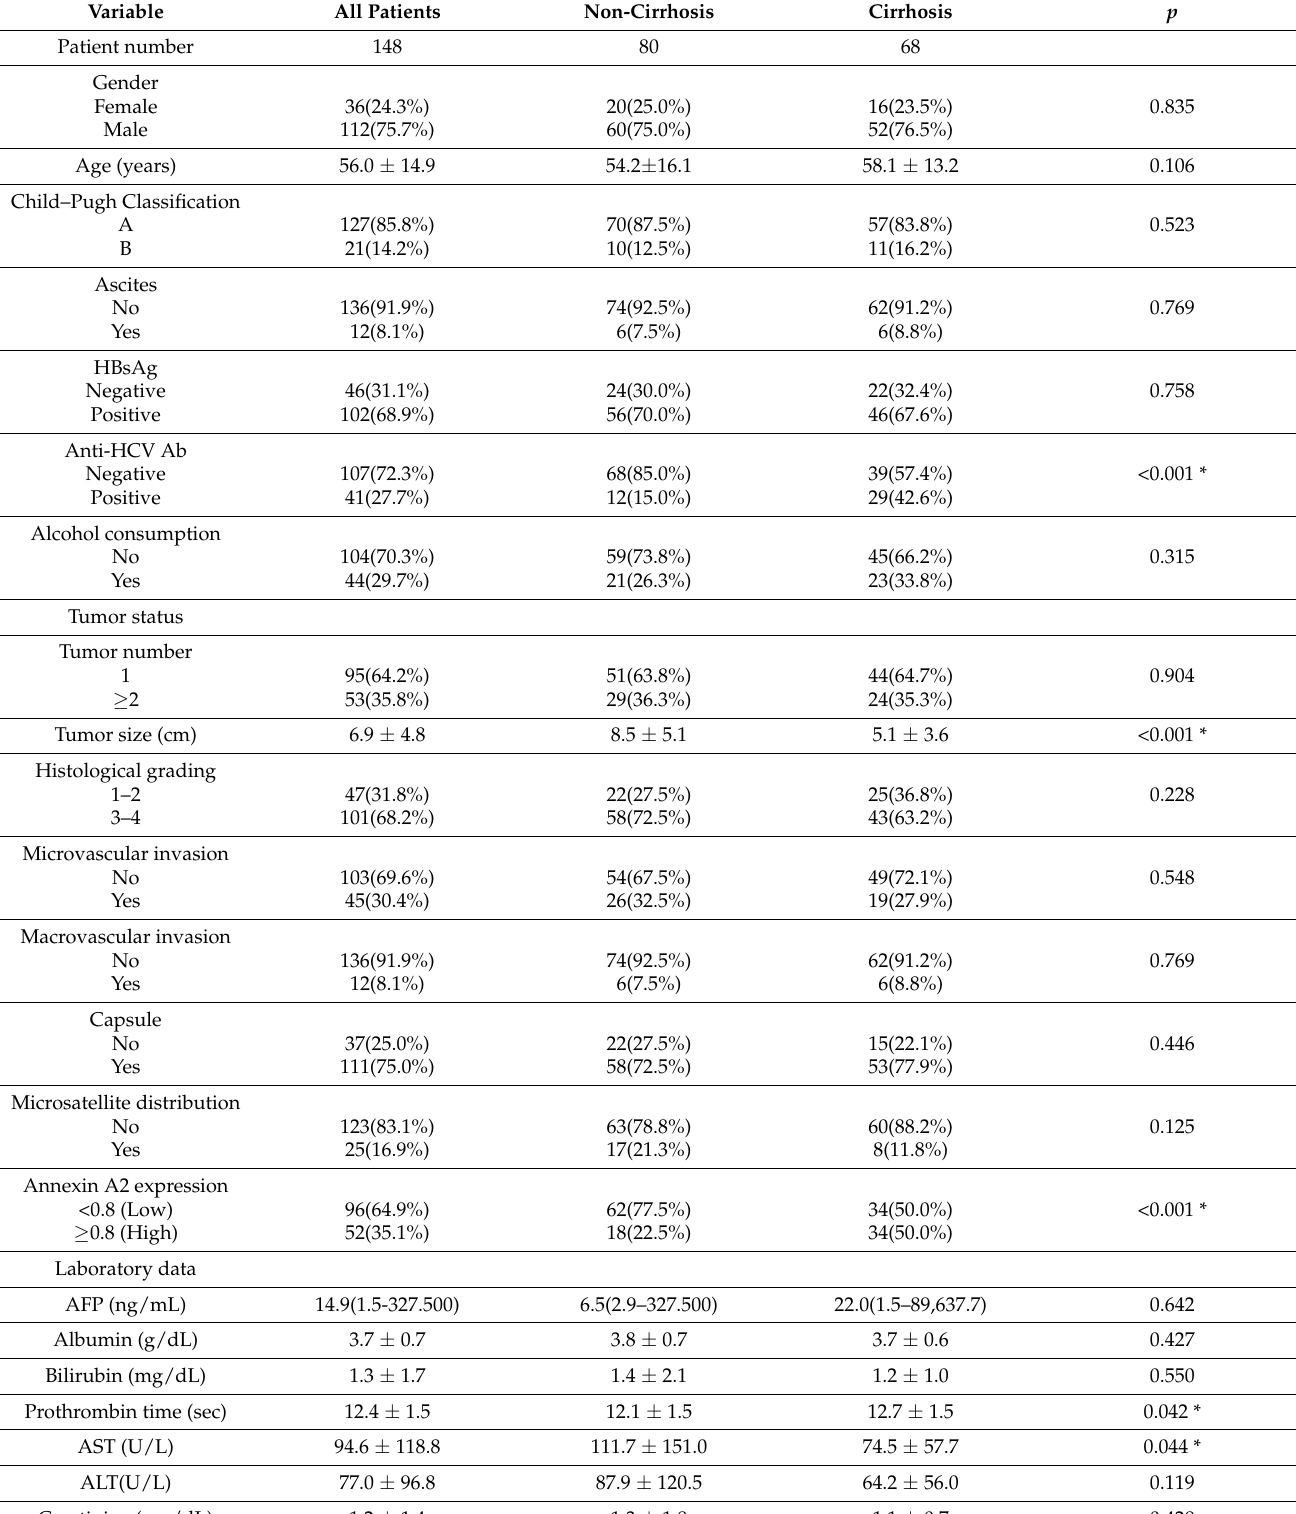
Table 1. Basic clinicopathological factors of patients with or without liver cirrhosis (cohort